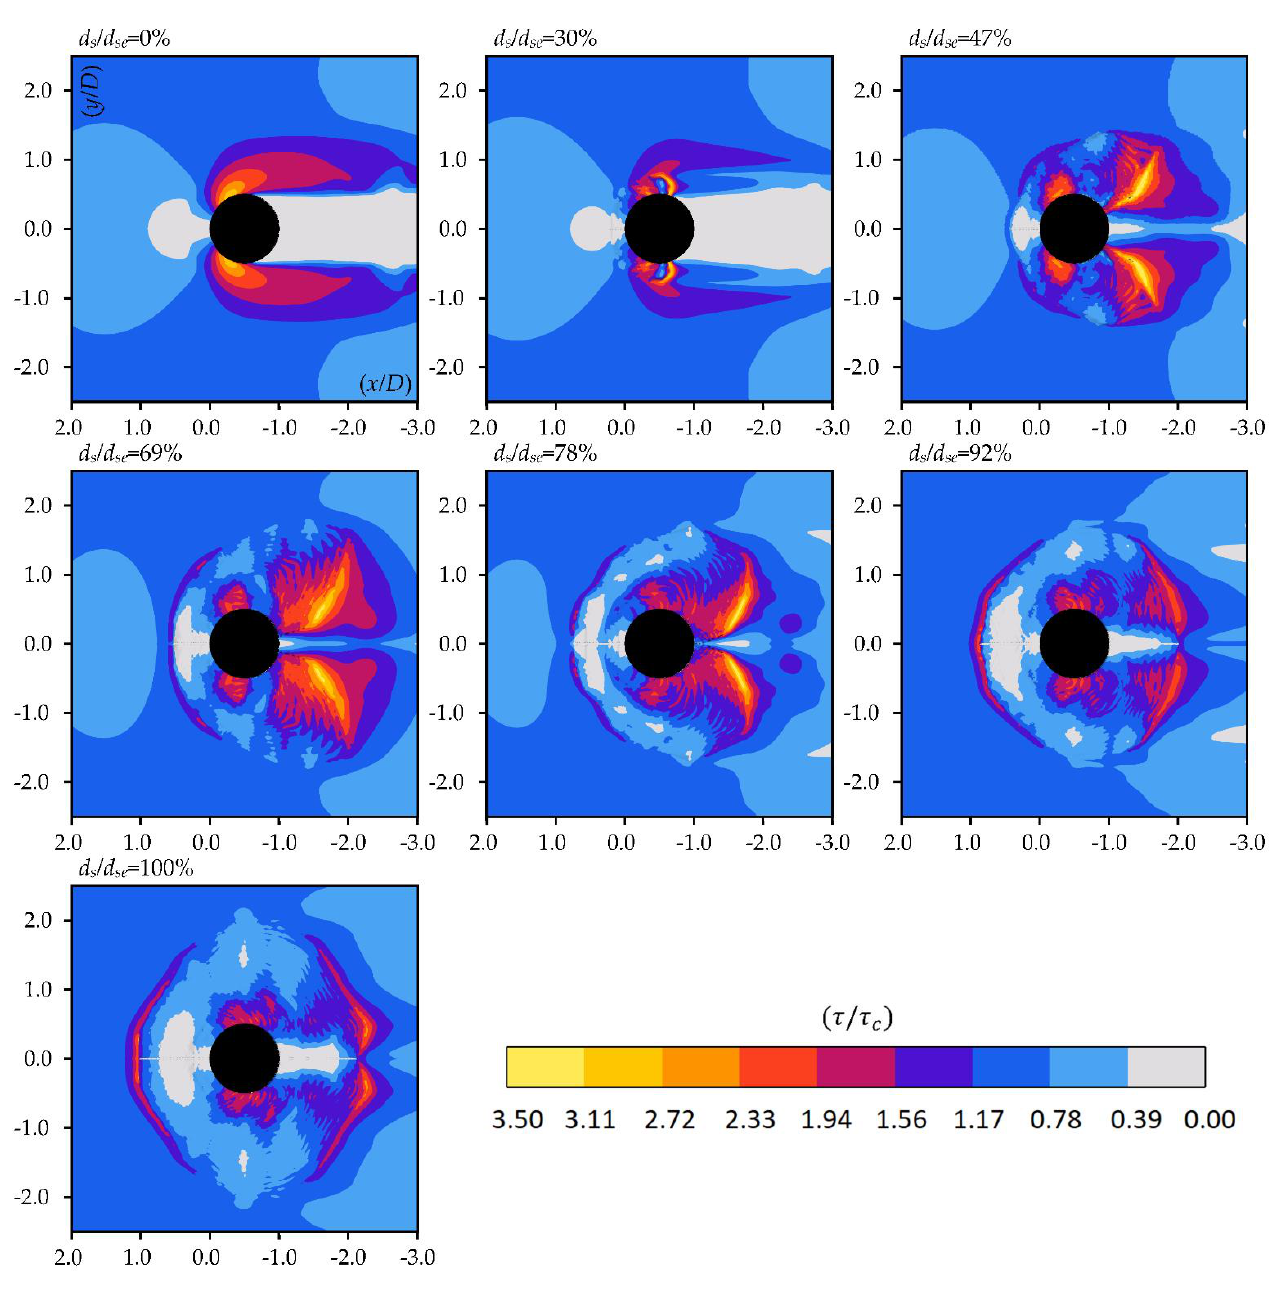
Figure 20. The shear stress distribution during scour